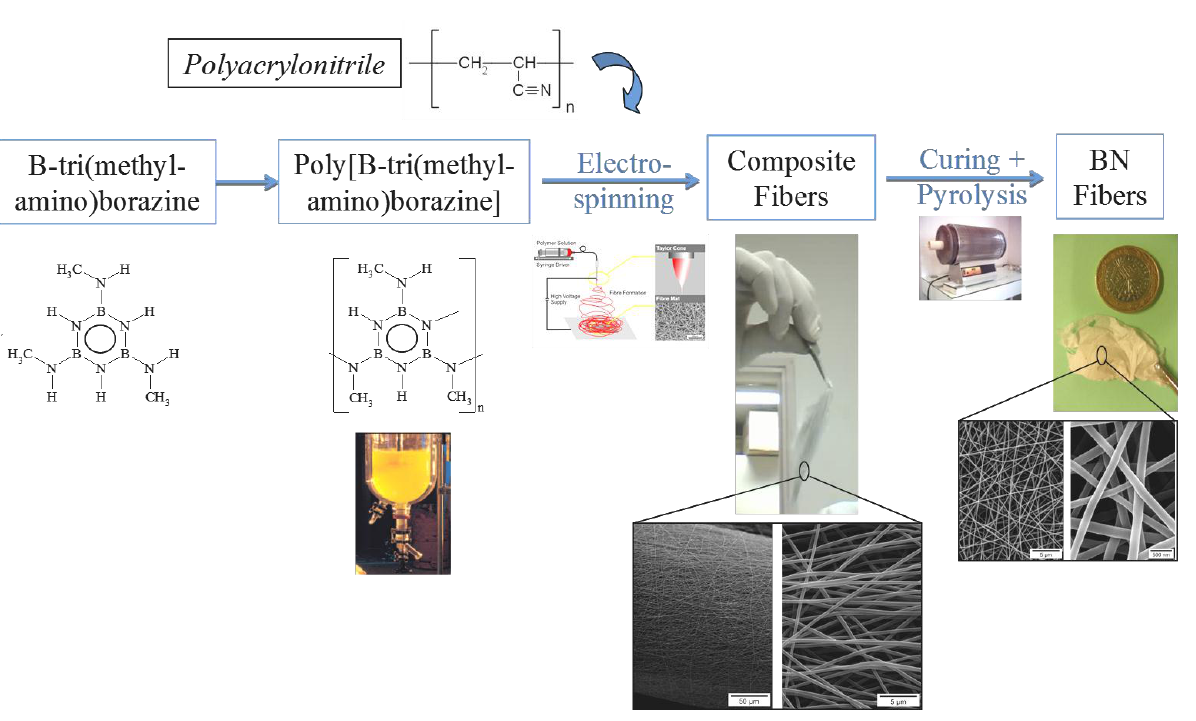
Figure 13. Overall process for preparing BN fibers by electrospinning, curing and